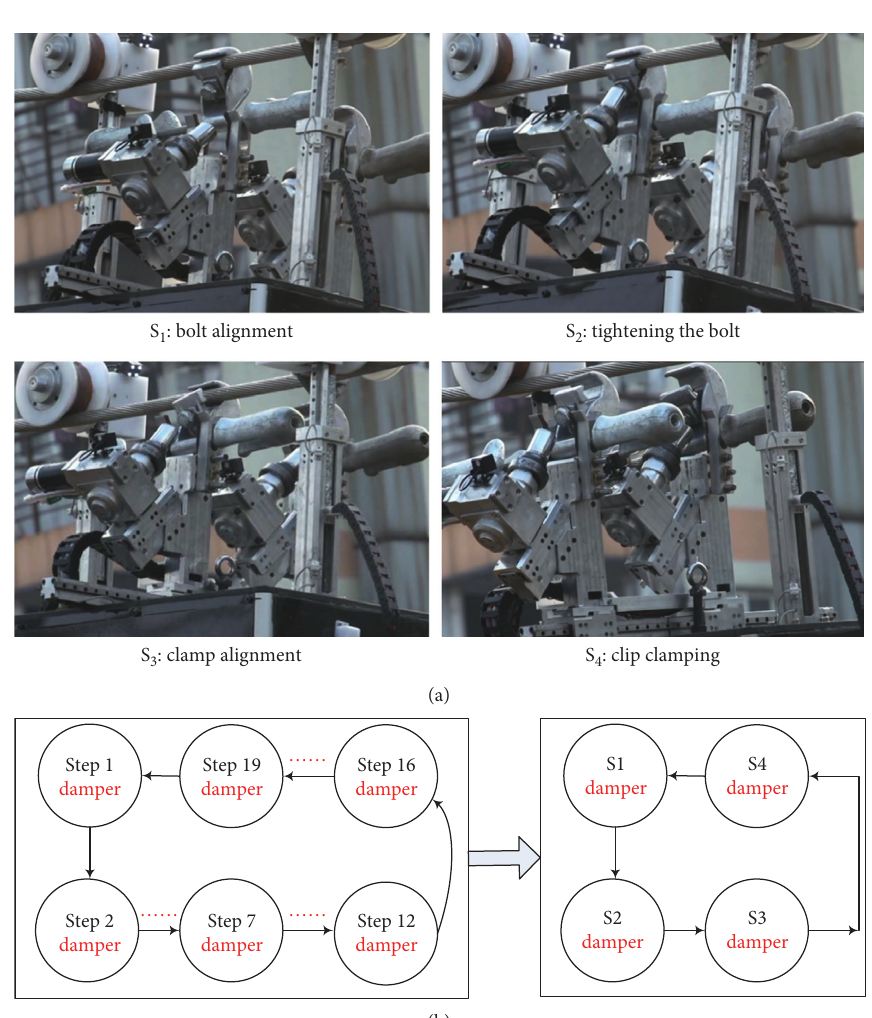
Figure 16: Field experiment of autonomous behavior control for damper replacement robot. (a) Damper operation main process. (b) Damper operation FSM